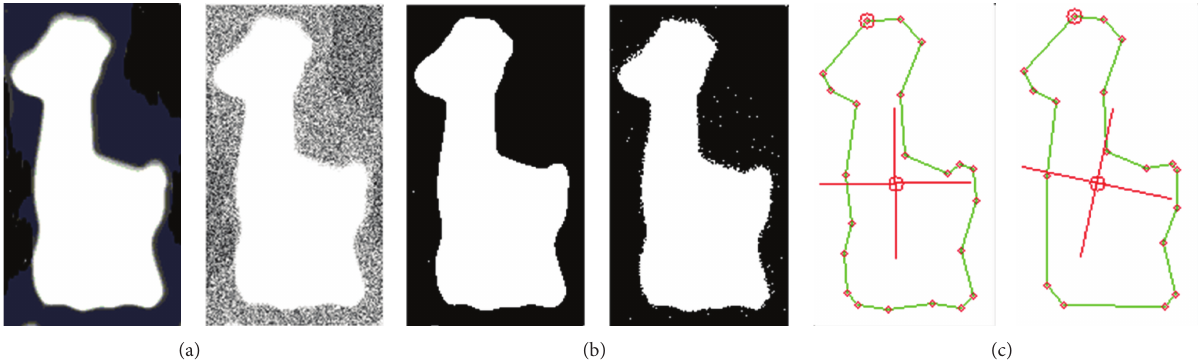
Figure 14: The shape “Giraffe” with and without noise: (a) grey image, (b) binary image, and (c) contour polygon.